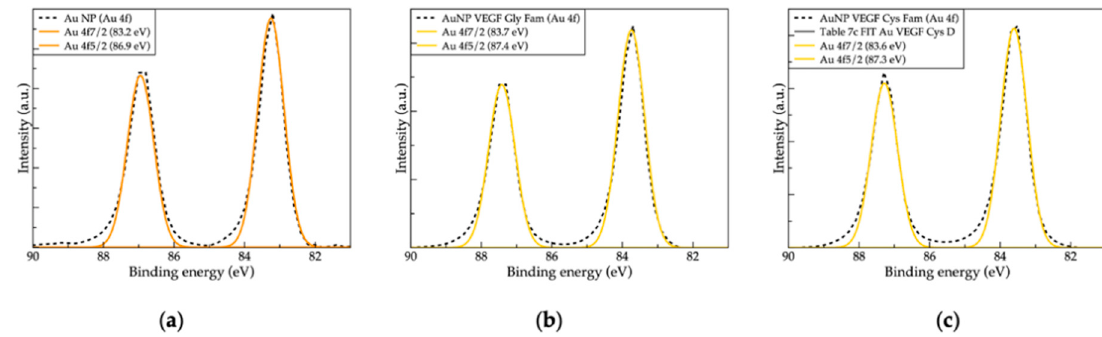
Figure 7. Representative high-resolution spectra of Au 4f of bare AuNPs ( a ), AuNPs/VEGF Gly FAM ( b ) and AuNPs/VEGF Cys FAM ( c ).